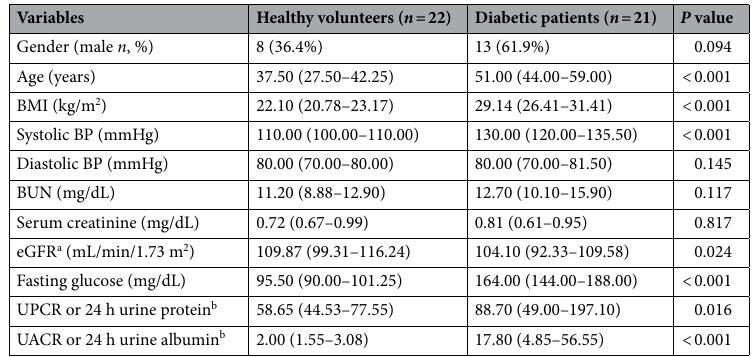
Table 1. Baseline characteristics of participants. Values are expressed as n (%) for gender and median (interquartile range) for continuous data. BMI body mass index, BP blood pressure, BUN blood urea nitrogen, eGFR estimated glomerular filtration rate, UACR urinary albumin to creatinine ratio, UPCR urinary protein to creatinine ratio. a The eGFR was calculated using the chronic kidney disease epidemiology collaboration (CKD- EPI) formula. b The 24 h urine protein and albumin (mg/day) were tested in healthy volunteers, and spot urine protein and albumin to creatinine ratio (mg/g) were evaluated in diabetes